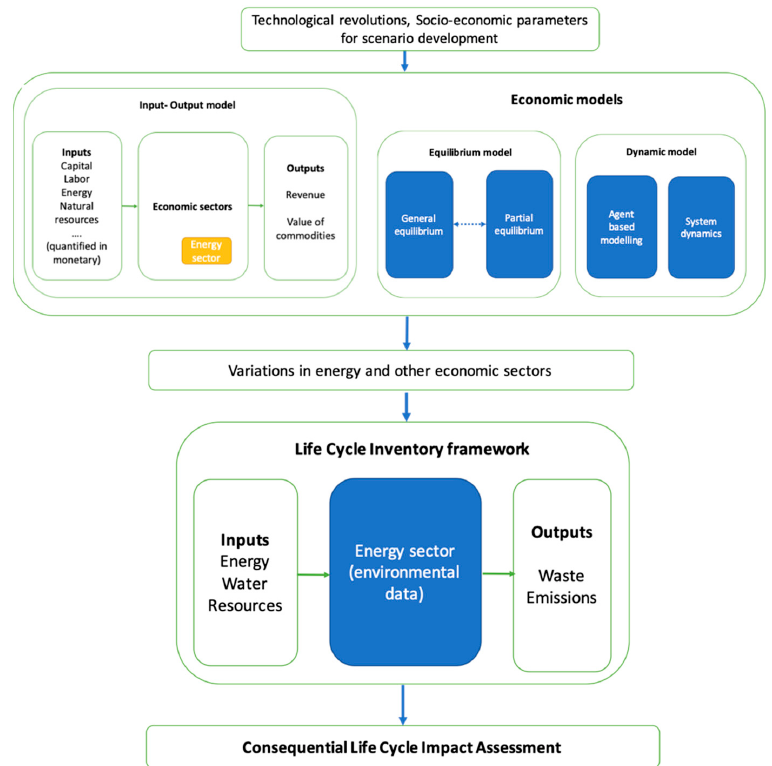
Figure 2. Economic models and Life cycle assessment (LCA) for consequential LCA (adapted from [38]).